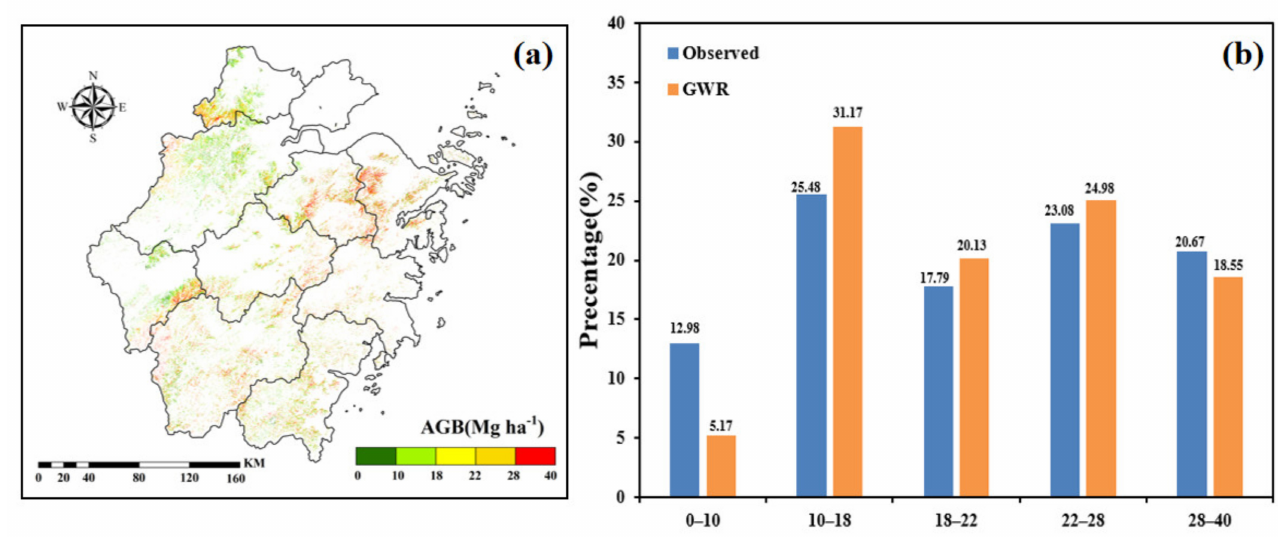
Figure 8. ( a ) The GWR model inversion of AGB in Zhejiang Province in 2014 and ( b ) percentage of spatial variation of AGB observed in sample plots and the percentage of spatial variation of the bamboo forest AGB estimated by the GWR models.